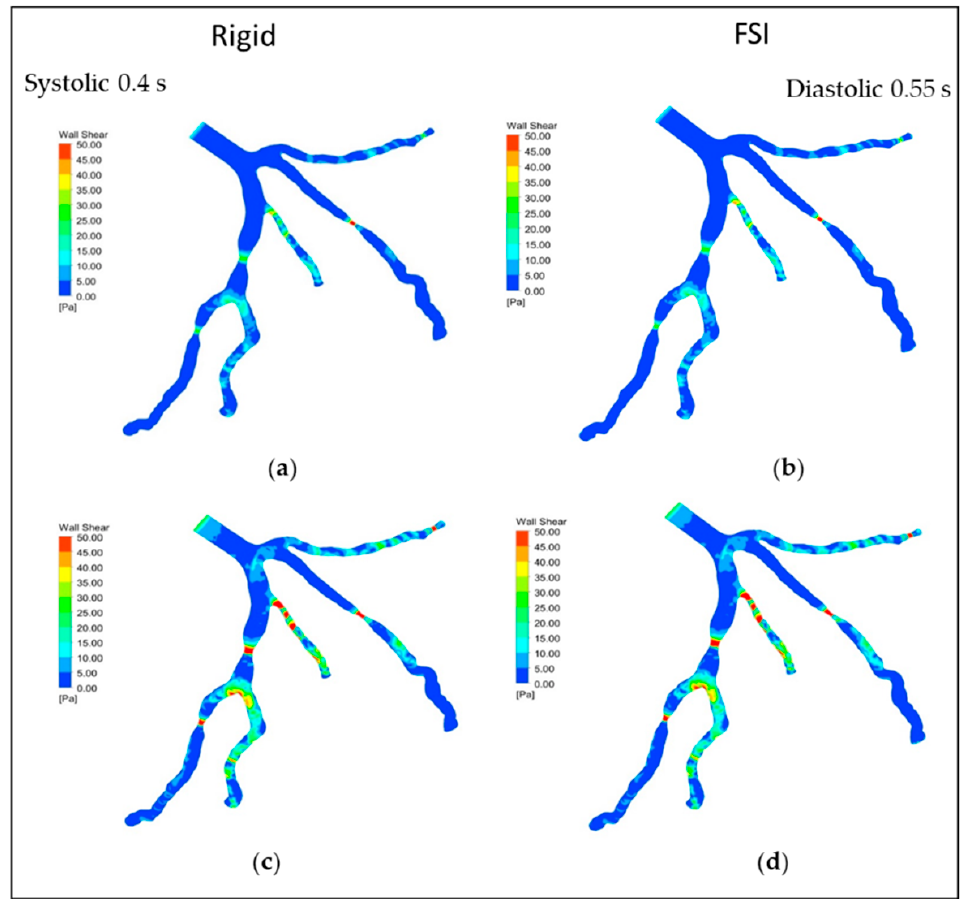
Figure 7. Wall shear stress field in the left coronary artery during the systolic and diastolic phase of cardiac cycle for ( a , c ) rigid and ( b , d ) fluid–solid interaction (FSI) models.